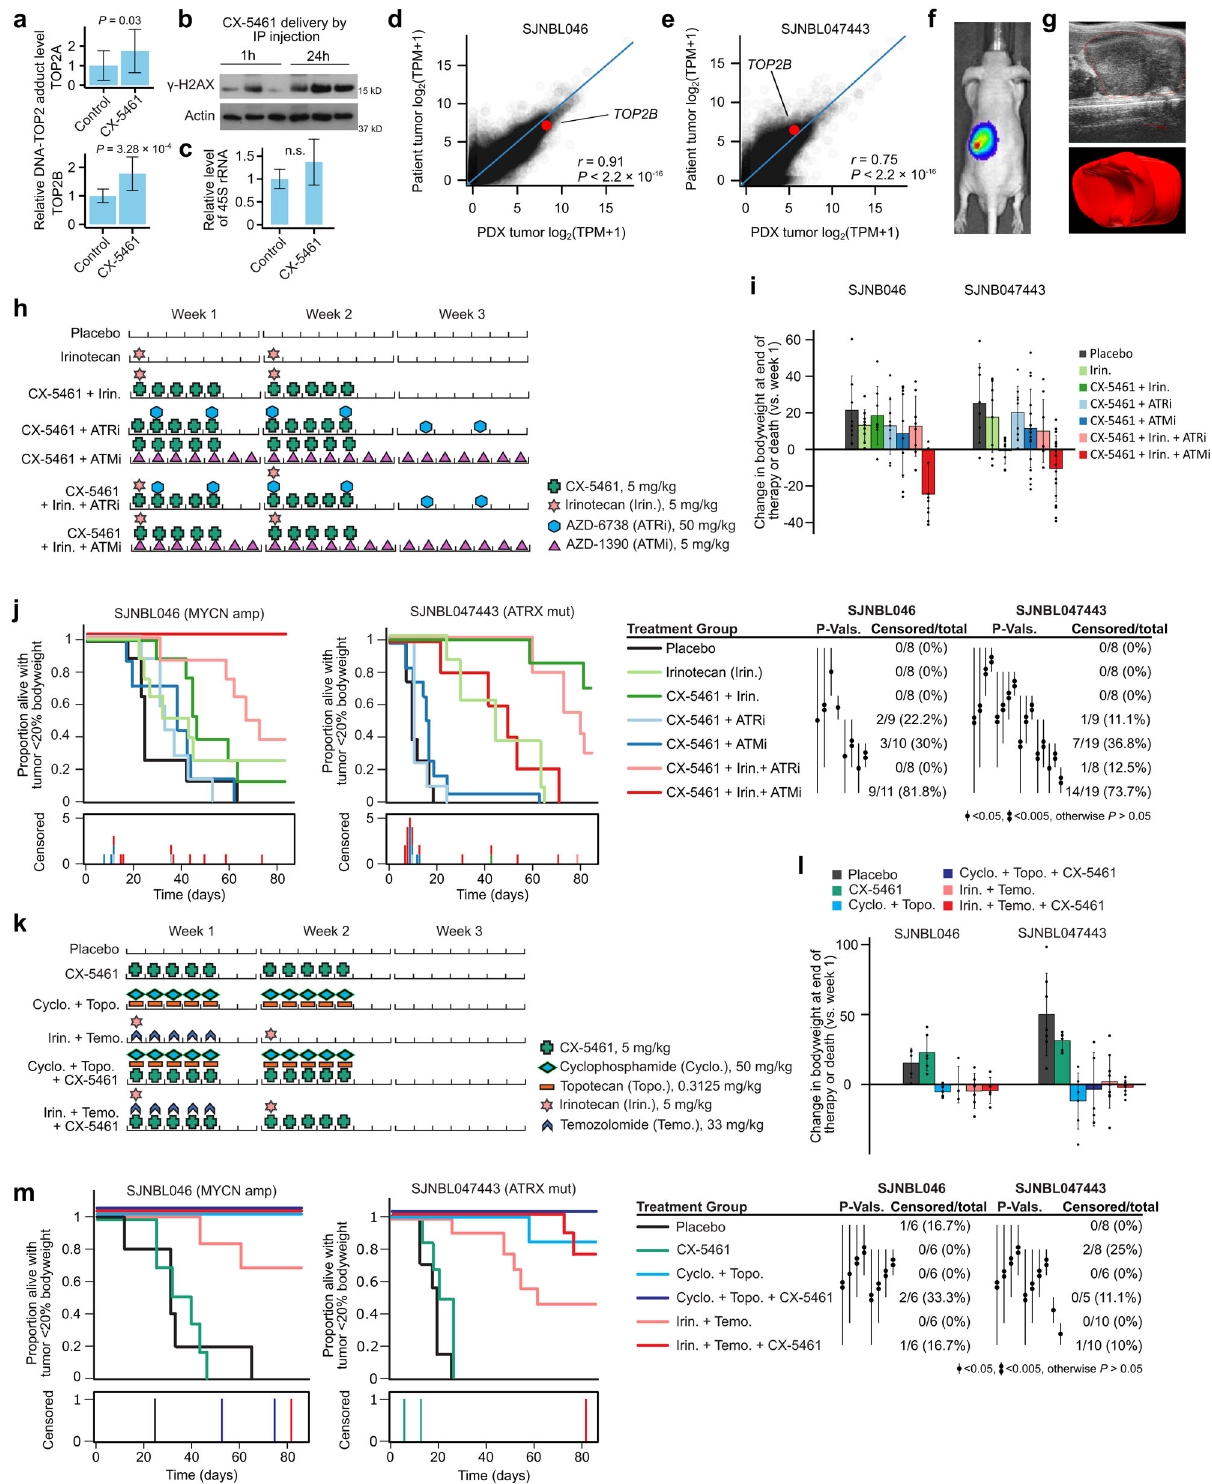
recently been shown to be mutagenic in a C. elegans model 70 , contradicting earlier claims that it is not genotoxic 21 . Thus, our fi nding that CX-5461 primarily targets TOP2B provokes serious safety concerns, and patients enrolled in ongoing CX-5461 phase II trials should be closely monitored for these late-emerging TOP2B - related adverse events. TOP2B is also particularly highly expressed in the brain, suggesting that blood-brain barrier penetration should be formally